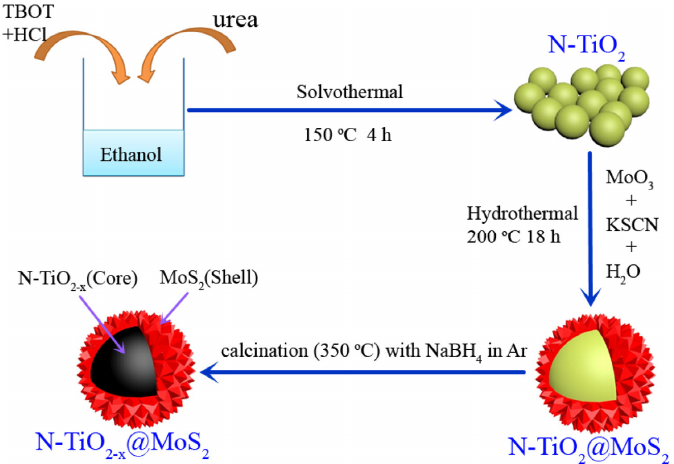
Figure 12. Schematic diagram for the formation of the N-TiO 2 -x@MoS 2 nanocomposites. Copyrights 2017 Elsevier [135].